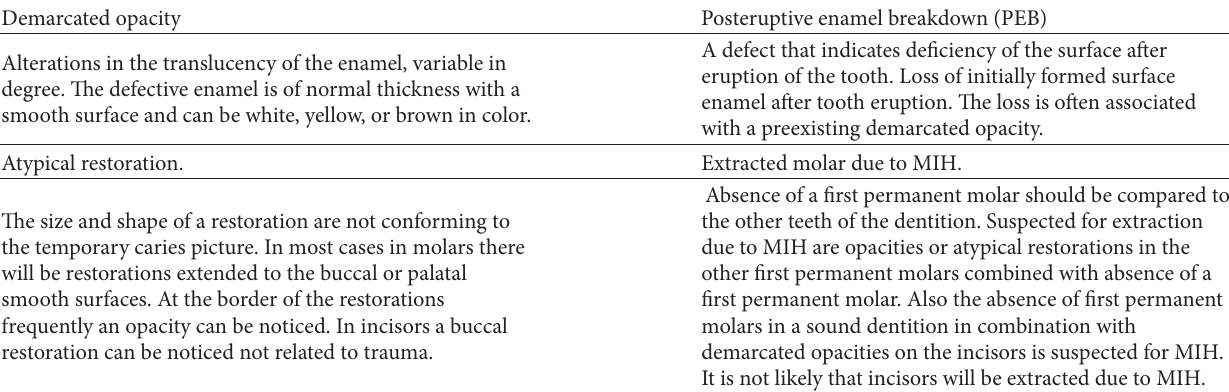
Table 1: Diagnostic criteria used in diagnosing MIH ∗ .